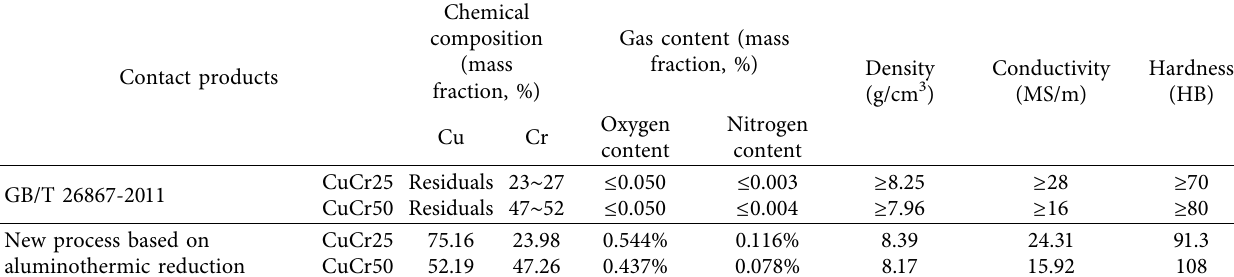
Figure 25: Macroscopic photograph and microstructure of CuCr alloy by aluminothermic reduction-magnetoelectric coupling refining- water and gas composite cooling. (a) CuCr25. (b) CuCr50 [78, 79]. Table 3: Chemical composition and mechanical and physical properties of CuCr contacts [58].